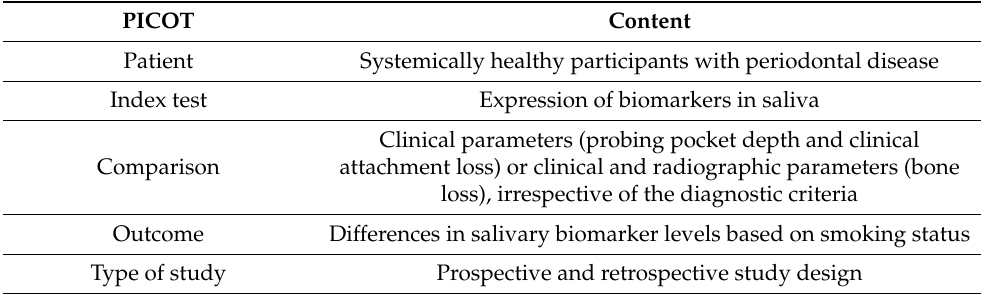
Table 1. Formulated research questions for the systematic